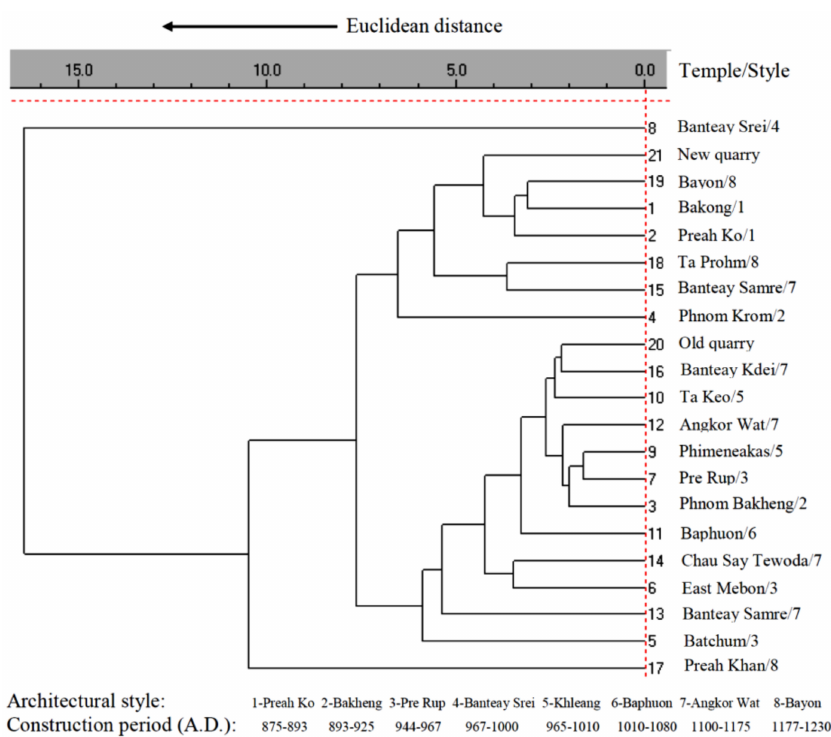
Figure 3. Dendrogram of sandstone elemental composition of Angkor temples (according to